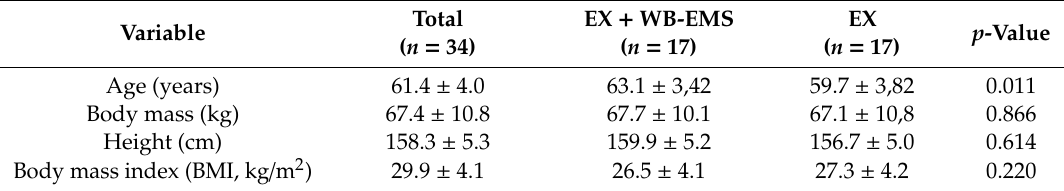
Table 1. Sample’s characteristics.